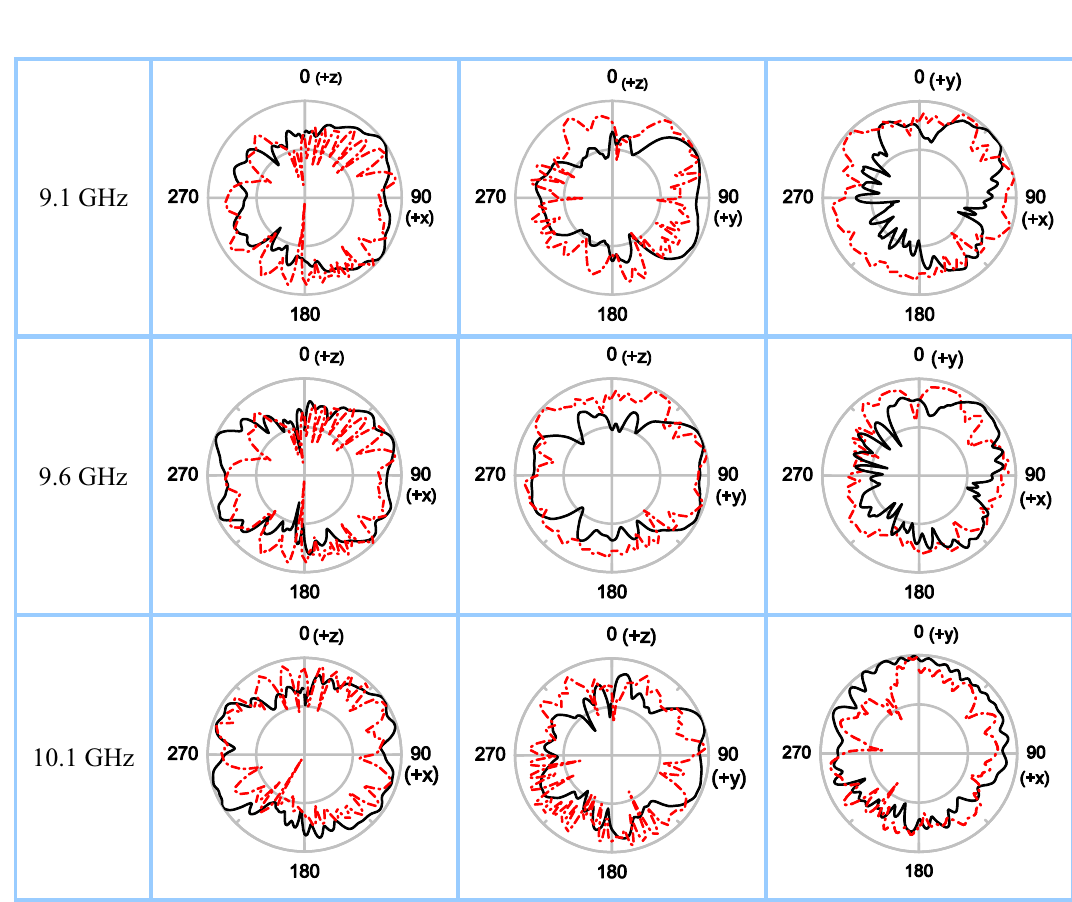
Figure 7. Normalized radiation patterns in xoz -, yoz -, and xoy -plane at 9.1, 9.6, and 10.1 GHz (black solid line for simulated results and red dash dot line for measured